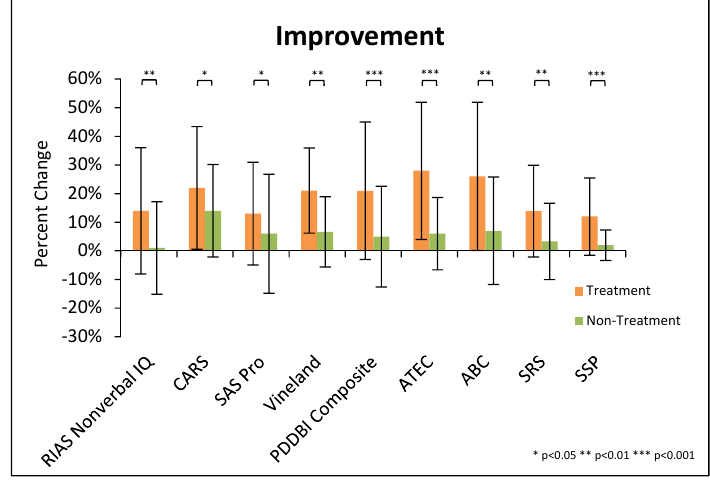
Figure 2. Summary of significant changes in major evaluations, for both the treatment and non ‐ treatment groups. For some scales an increase is an improvement, and for some the opposite is true; so, here we plot them with improvement being in the same direction on the y ‐ axis. Note that the % change for the PDD ‐ BI composite is based on the average change in each of the composite subscales. Error bars represent standard deviations.